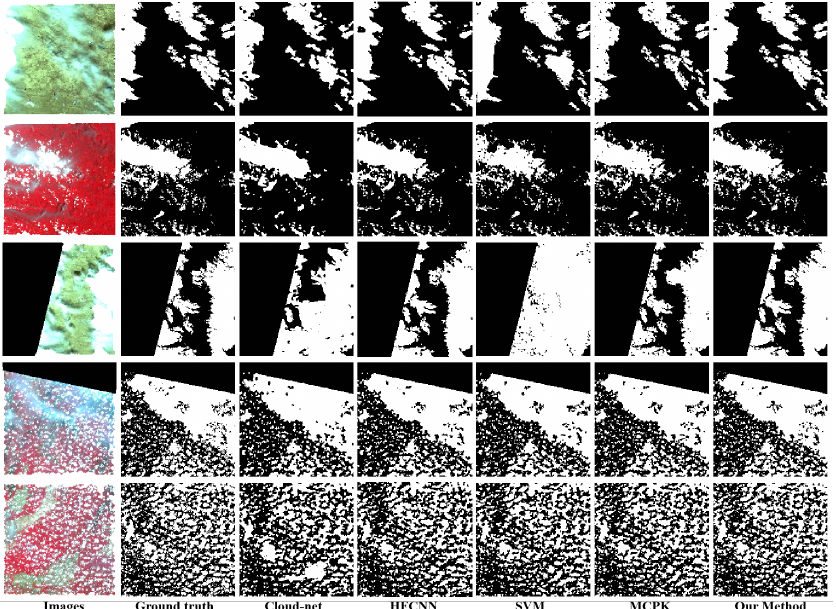
Figure 4. The performance of several methods on GF-1_WHU dataset [32] with different cloud distribution styles.